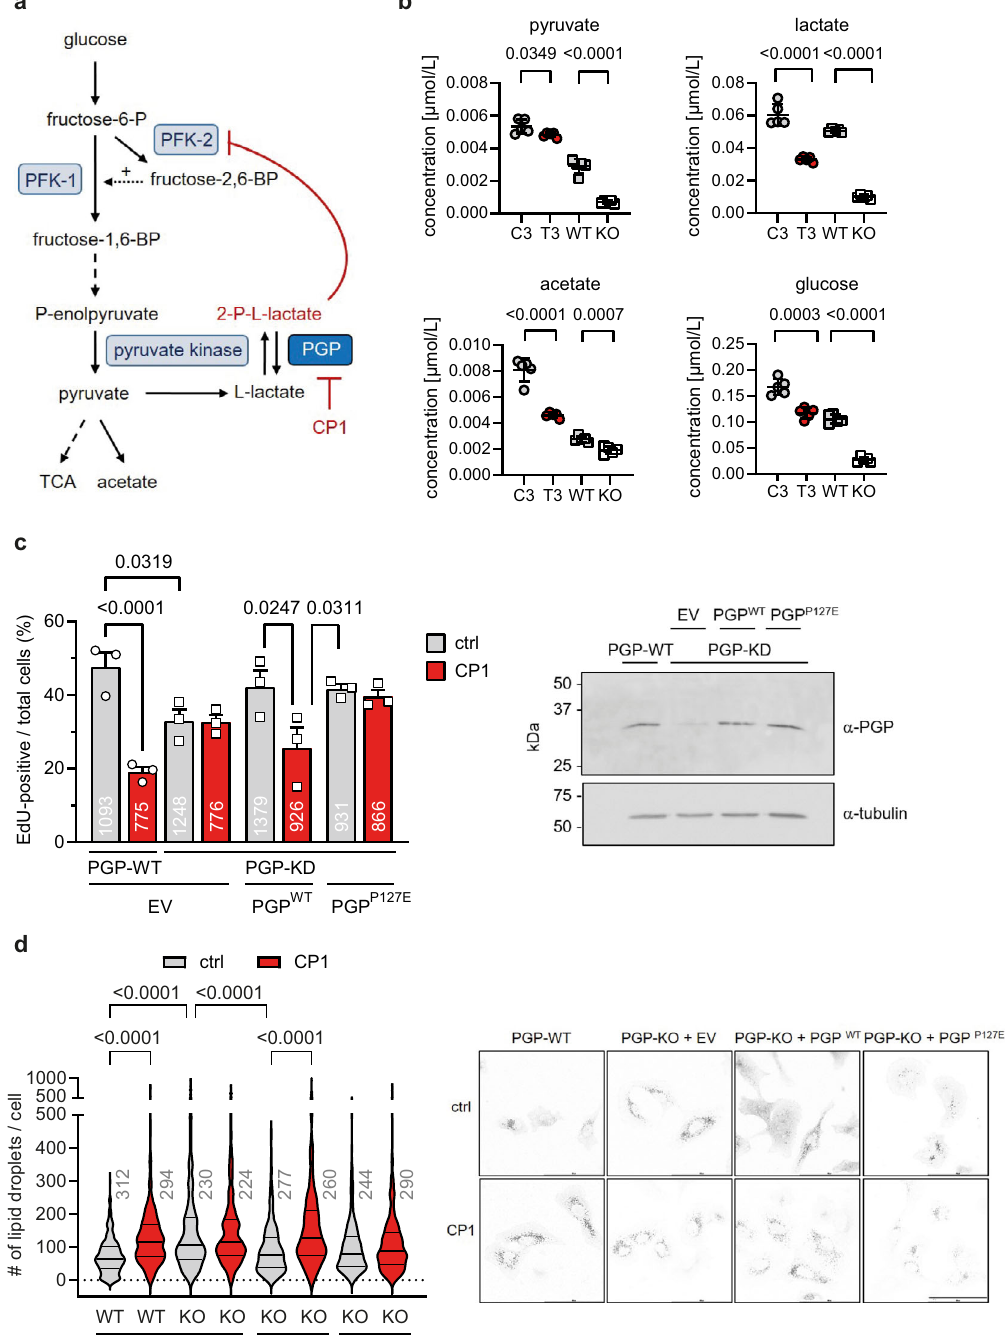
Fig. 5 | Effects of CP1 in cells. a Left panel, role of PGP in glycolysis. 2-Phospho-L- lactate(2PL),generatedbypyruvatekinase,inhibitsPFK2.Thismechanismreduces the formation of the PFK1 activator fructose-2,6-bisphosphate, and decreases gly- colytic fl ux. PGP maintains glycolytic fl ux by dephosphorylating 2PL. PFK1/2, phosphofructokinase-1/2; TCA,tricarboxylic acid cycle. b Quanti fi cation of cellular metabolites in HT1080 cells by NMR spectroscopy. Cells were treated for 3h with the DMSO solvent control (C3) or with 33 µ M CP1 (T3); PGP-WT (WT, clone D5) or PGP-KO (KO, clone C2) cells are shown for comparison. All data are mean values±S.D.of n =5biologicallyindependentexperiments.Statisticalanalysis:two- sided t -tests; p -values are indicated. c Effectof PGP de fi ciencyon cellproliferation. Left, EdU incorporation assays in PGP-WT (clone EV3) or PGP-KD (clone B1-10) HT1080cellstransfected withemptyvector(EV),PGP-WTorPGP-P127E.Cellswere treatedwithDMSO(ctrl)orCP1(100 µ M).The totalnumber of scored cellsisgiven